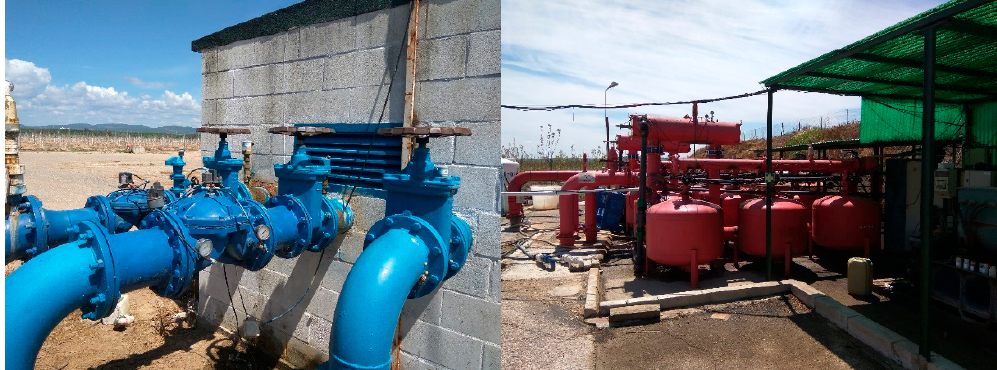
Figure 2. Hydrant and filter plant where the HPP will be